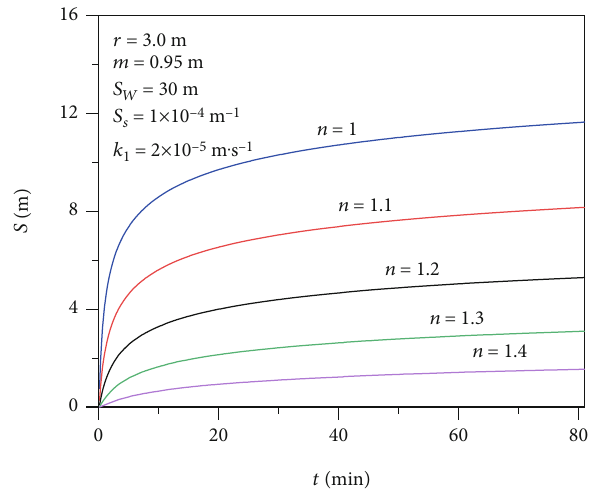
Figure 11: Hydraulic head in the aquifer ( r = 3 m) with m = 0 : 95 m, = 30 m, S = 1 × 10 − 4 m -1 , and k = 2 × 10 − 5 m/s for the values of s s 1 w power index n = 1 , 1.1, 1.2, 1.3, and 1.4,